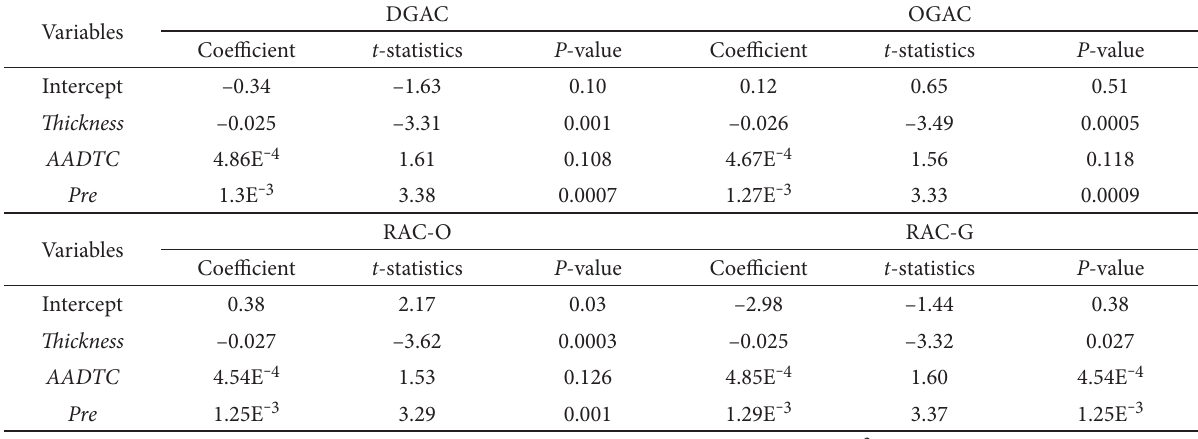
Table 2. Parameter estimation and Goodness-of-Fit measures of MNL